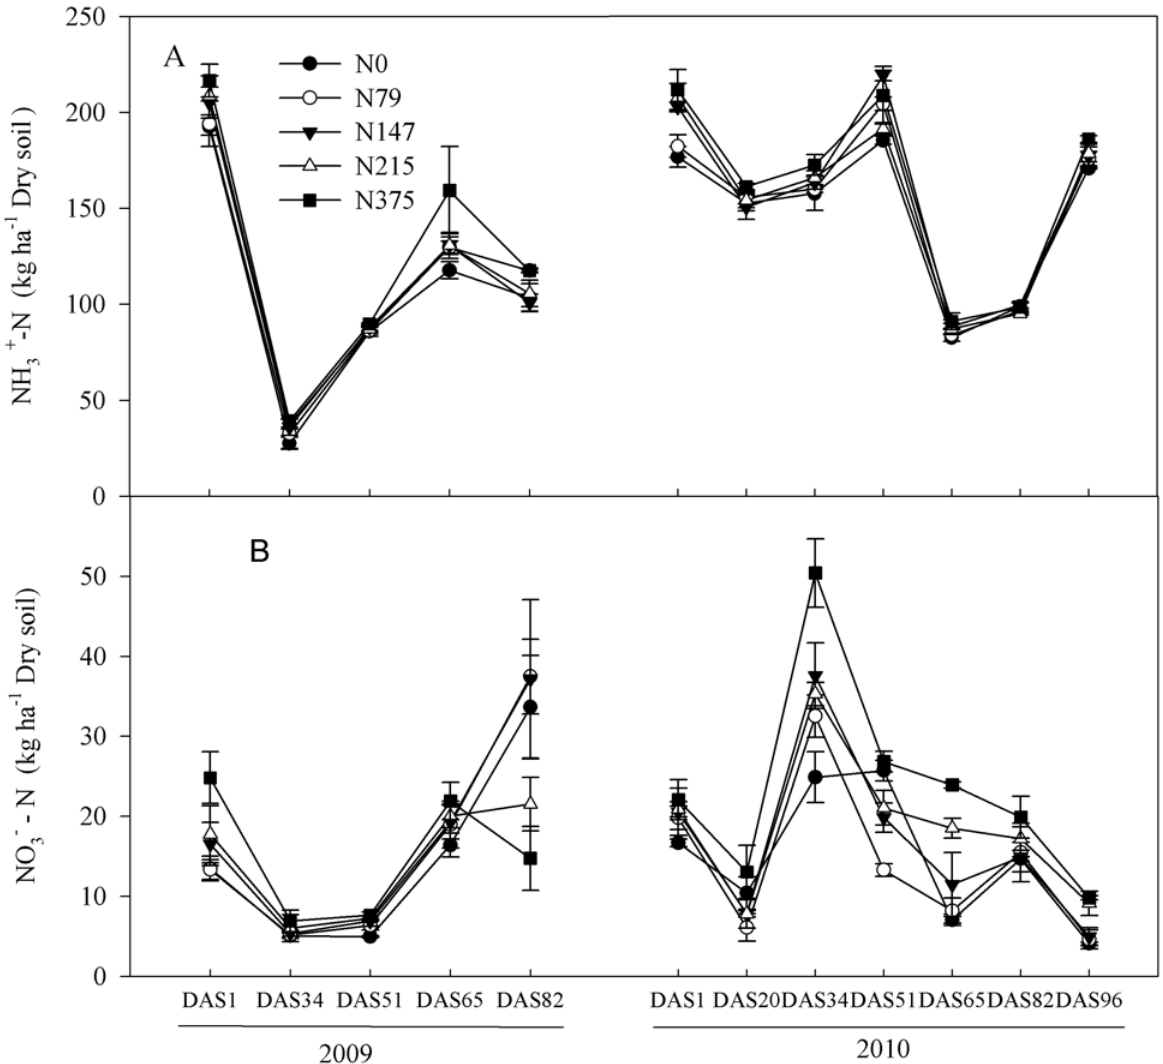
Fig 3. Dynamics of soil extractable NH4 + -N (A), and NO3 - -N (B) at different days after sowing (DAS) in the field trial during maize growth season (June.12 — Sep.29) in 2009 and 2010. Each point is mean of 4 replicated plots. Error bars represent ± 1